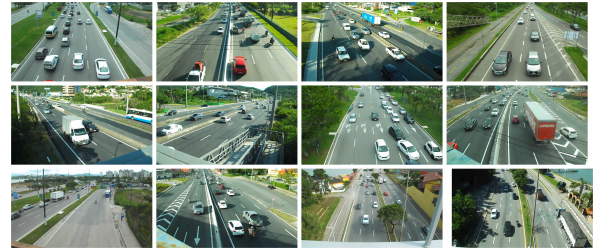
Figure 1. Some images from the dataset under different scenarios.